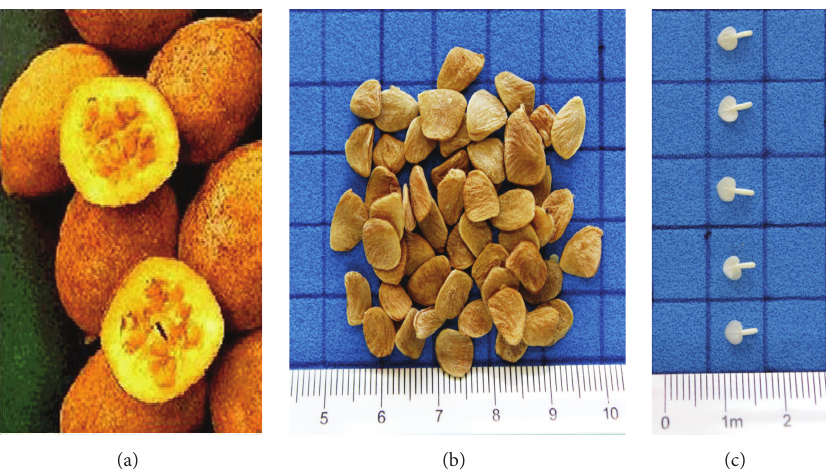
Figure 1: Fruits, seeds, and embryonic axes of Genipa americana L.: (a) mature fruits (6–8 cm in diameter); (b) sample of whole seeds ready for use, after they were extracted from mature fruits and dried overnight at room temperature ( average size : 8.5 × 6.4 × 2.0 mm; average weight : 0.096 g); and (c) embryonic axes ready for inoculation in vitro after they were excised from seeds in aseptic conditions in the laminar flow cabinet ( average size : 3.0–5.0 mm, on